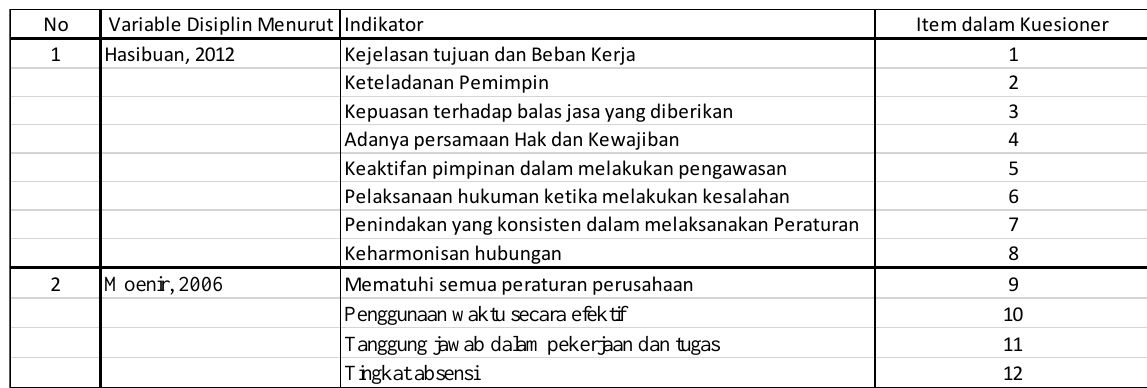
Tabel 3 Indikator untuk Variabel Displin